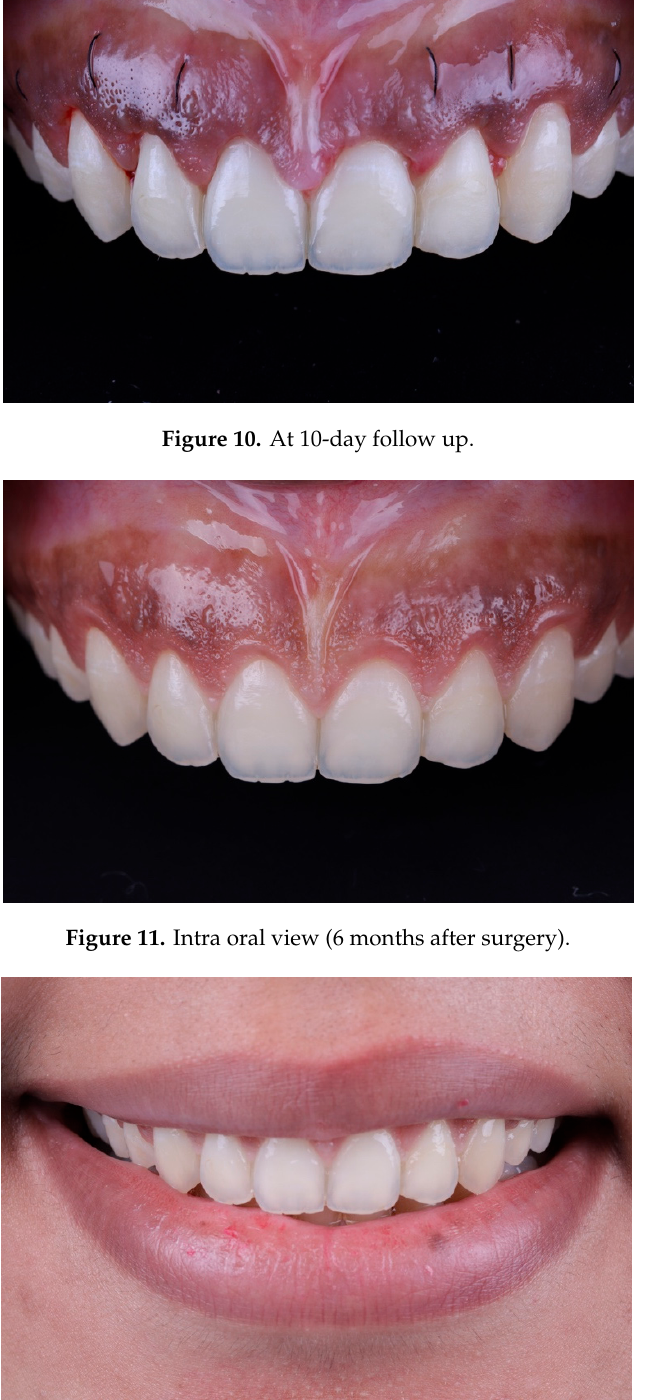
Figure 12. Smile view (6 months after surgery).